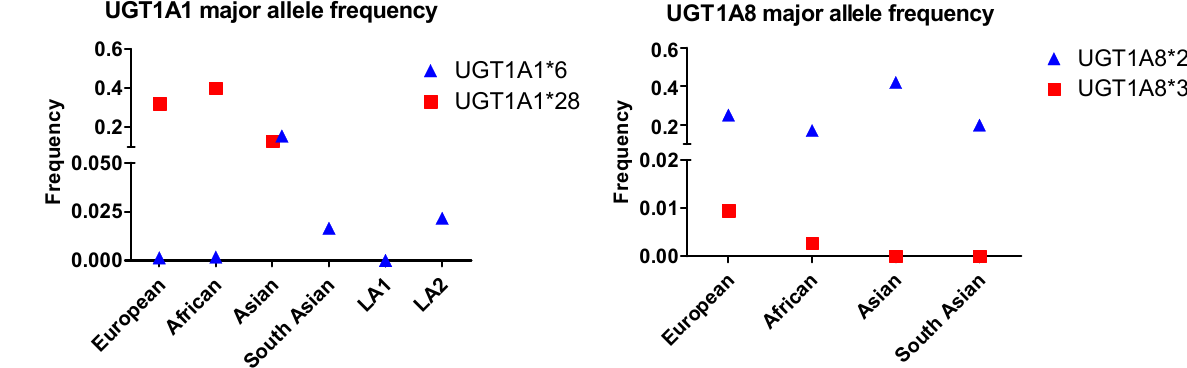
Figure 4. The allele frequency of two UGT1A1 and UGT1A8 SNPs in different populations. Asian: All Asian individuals excluding South Asians; LA1,:Latin American individuals with Afro-Caribbean ancestry; LA2: Latin American individuals with mostly European and Native American Ancestry. Data for the UGT1A1*6 and UGT1A1*28 alleles were extracted from NCBI ALFA project (version: 20200227123210, www.ncbi.nlm.nih.gov/snp/docs/gsr/alfa/ [17]).